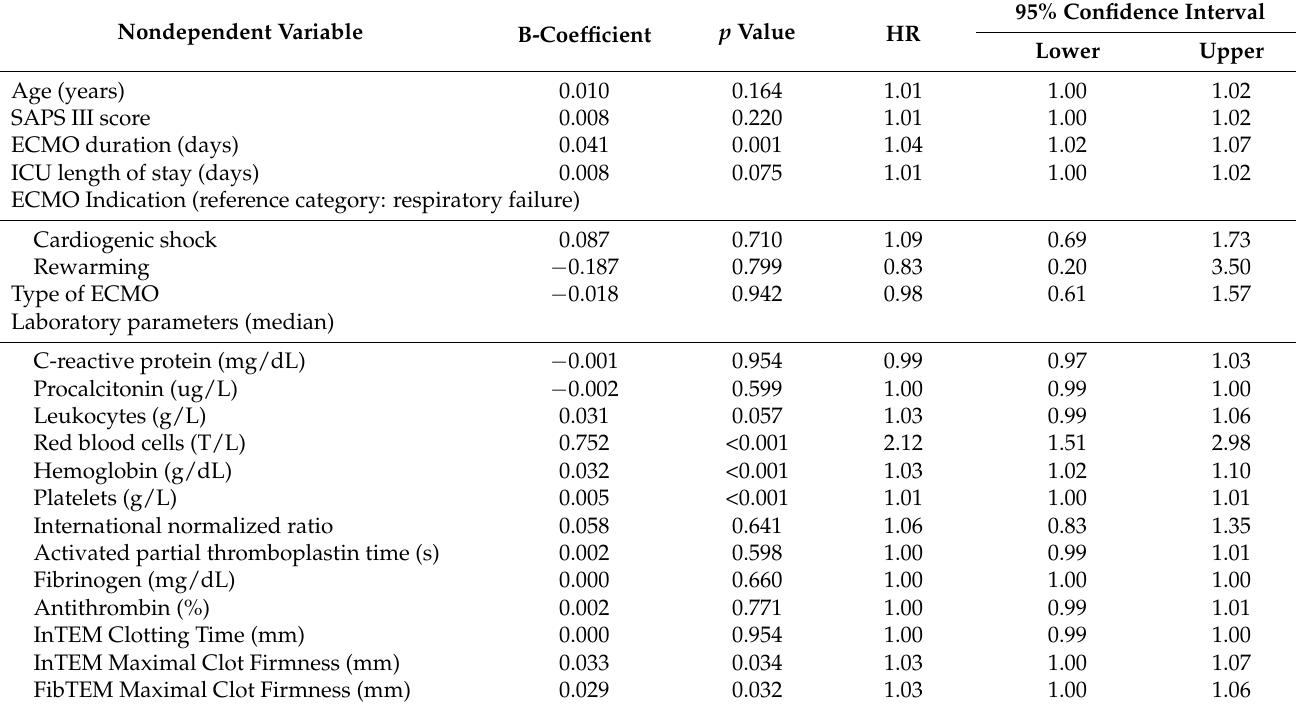
Table 4. Univariate analyses: Variables with potential association with thrombosis (n = 417).